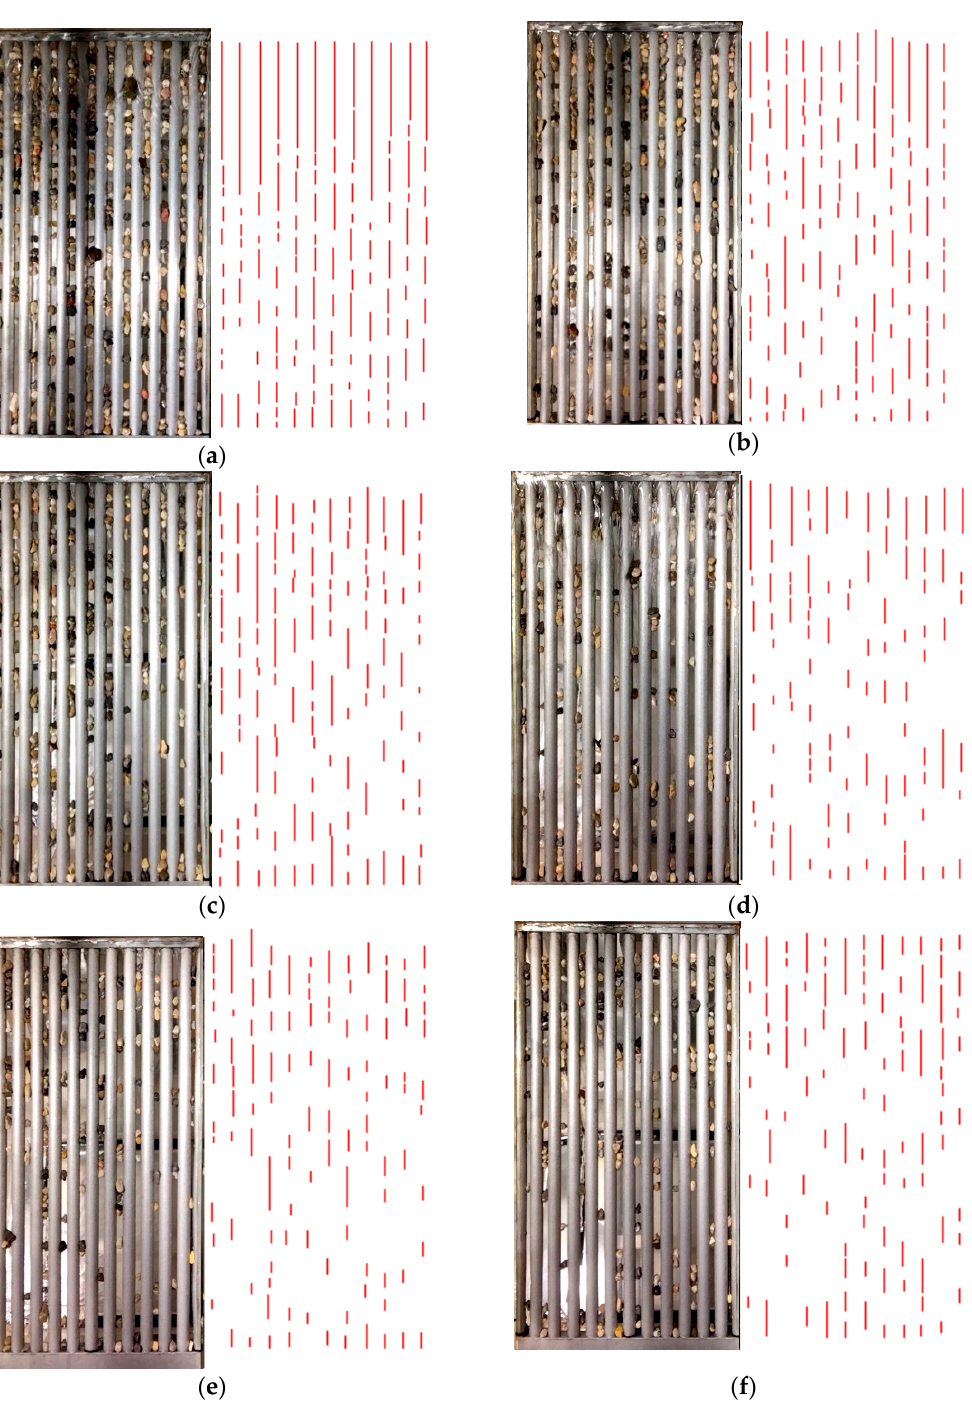
Figure 7. Top view of occluded bottom racks with circular bars for m = 0.28, q 1 = 138.3 l/s/m, and diverse longitudinal slopes: ( a ) 0%; ( b ) 10%; ( c ) 20%; ( d ) 30%; ( e ) 33%; and ( f ) 35%.